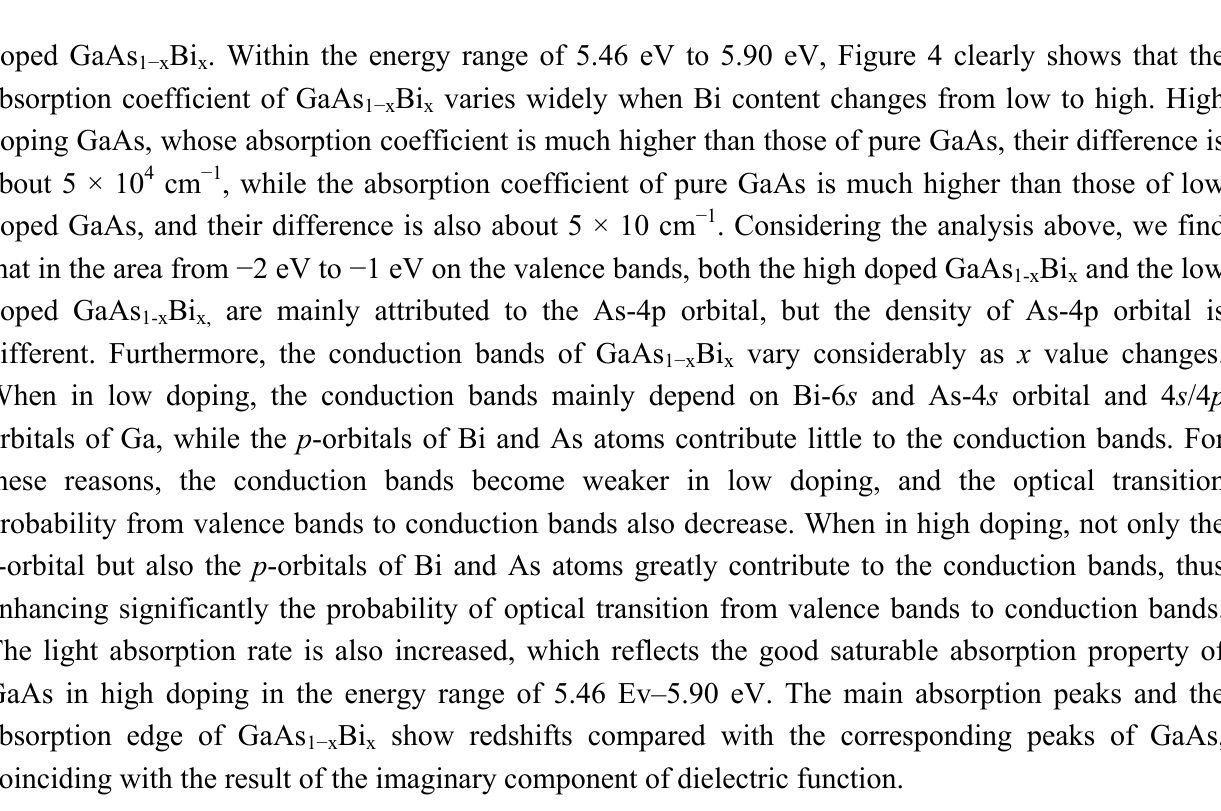
Figure 4. The absorption spectrum of GaAs